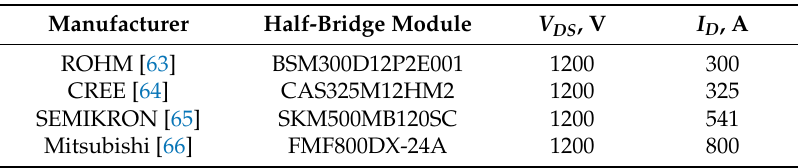
Table 1. Commercially available all SiC power MOSFET half-bridge modules that can be employed in central inverter in Figure 1a/by February